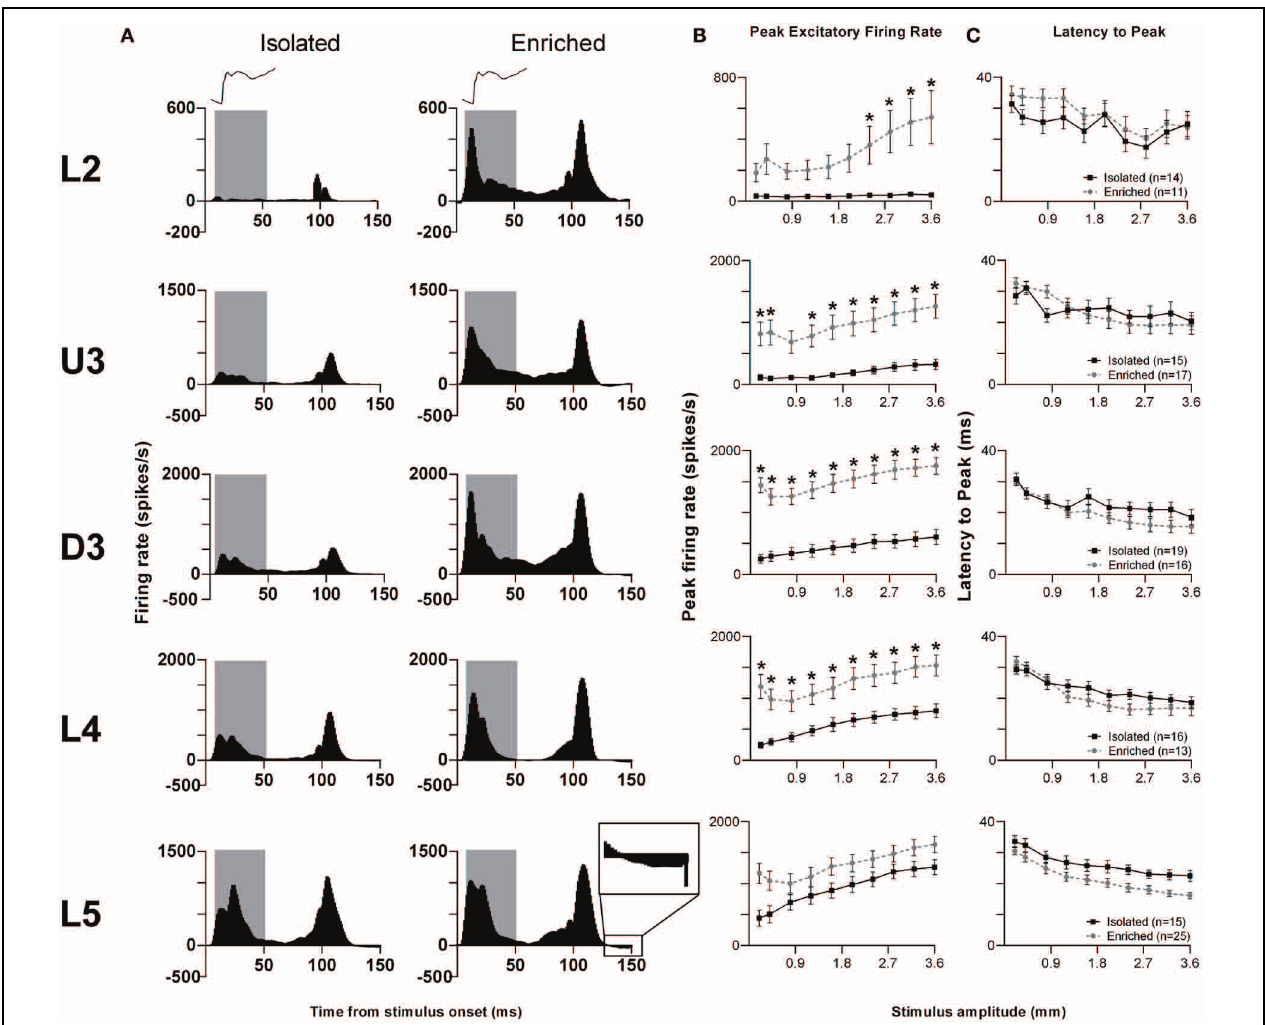
FIGURE 2 | EE effects on pattern, strength and timing of responses evoked by the object contact stimulus. For this complex stimulus, response strength significantly increased in all layers from Layer 2 to Layer 4 after EE, with no changes in response timing. (A) Population Grand PSTHs in response to the trapezoid with the fastest onset ramp velocity (400mm/s) in a specific lamina (indicated to left of panel) in EE and Isolated animals. Laminar designations: L2, Layer 2; U3, Upper Layer 3; D3, Deep Layer 3; L4, Layer 4; L5, Layer 5. Each Grand PSTH was generated by averaging responses across all responsive clusters in that lamina. The analysis window used to extract response metrics is